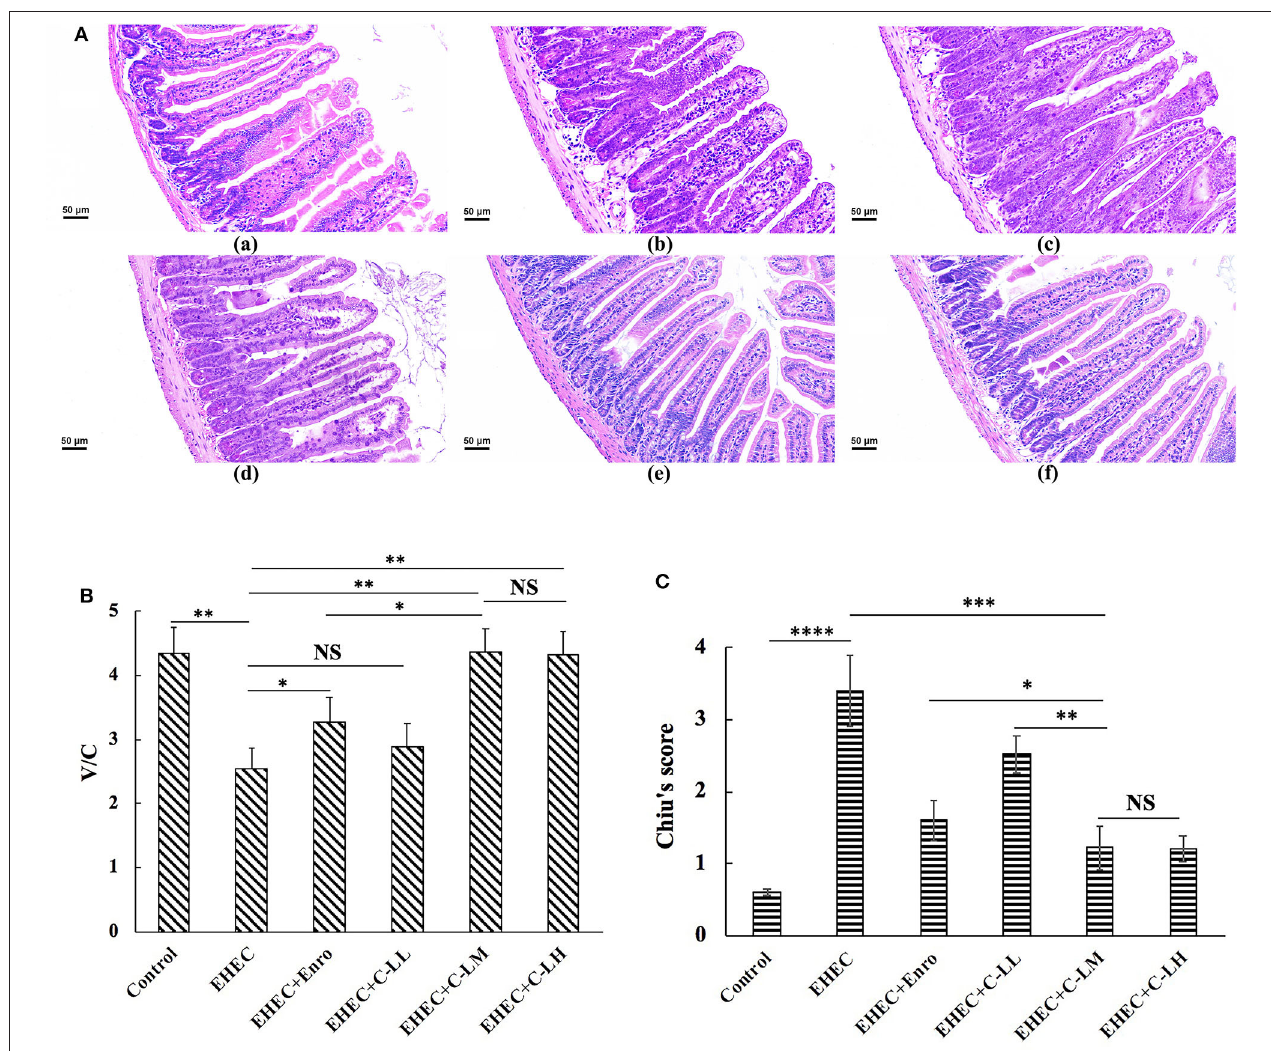
FIGURE 3 | The protective effects of C-L against EHEC-induced clinical symptoms in the mouse jejunum. Representative H&E-stained sections from mice in the ( A -a) control, ( A -b) EHEC, ( A -c) EHEC + Enro, ( A -d) EHEC + C-LL, ( A -e) EHEC + C-LM, and ( A -f) EHEC + C-LH groups. Scale bar, 50 µ m. (B) The effect of C-L on the jejunum V/C ratio. (C) The effect of C-L on Chiu’s score. The control group was orally administered 100 µ L sterile PBS; the EHEC group was orally administered 100 µ L sterile PBS containing 1 × 10 8 CFUs EHEC O157:H7; the EHEC + Enro group was orally administered 100 µ L sterile PBS containing 1 × 10 8 CFUs EHEC O157:H7 and then treated by i.p. injection with 8 mg/kg Enro once/day for 3 days; the EHEC + C-LL, EHEC + C-LM, and EHEC + C-LH groups were administered 100 µ L sterile PBS containing 1 × 10 8 CFUs EHEC O157:H7 and then treated by i.p. injection with 4, 8, and 16 mg/kg C-L, respectively, once/day for 3 days. The data are shown as the mean ± standard deviation ( n = 8). NS, P > 0.05; * P ≤ 0.05; ** P ≤ 0.01; *** P ≤ 0.001; **** P ≤